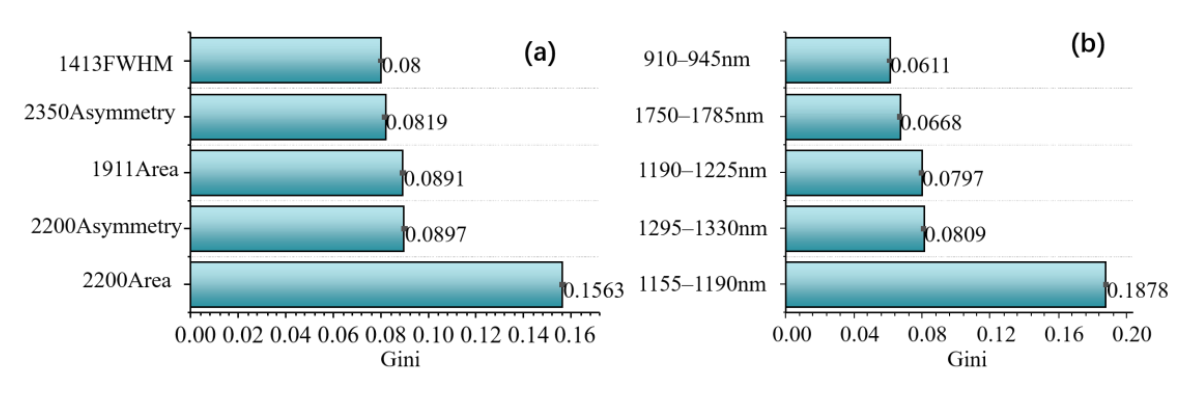
Figure 13. ( a , b ) Statistical chart of importance and the ranking of the predictors. The previous analyses, combined with the above indicative factors, have been used to map the absorption features, namely, the absorption wavelengths, areas, and depths. GF-5 advanced hyperspectral imaging (AHSI) was selected to extract the corresponding variables. The spectra around 1413 nm and 1911 nm of the GF-5 AHSI imagery cannot be used, due to an intense overprint caused by the corrections intended to remove the effects of atmospheric absorption from water vapor, and the stripe noise interference near 2350 nm is serious. Therefore, only the absorption features around 2200 nm were used to map in the GF-5 AHSI imagery, including the area around the 2200 absorption wavelength position (Figure 14a–c), 2200 Area (Figure 14d–f), absorption depth (Figure 14g–i) around 2200, and the first-order derivative of the bands (Figure 14j–l), while the random forest algorithm was used as the classifier. The results are shown in Figure 13, below. The layer-stacked image was then fed into the RF training model to recognize the distribution of the Li mine lithological classes (Figure 15). The metasediment of the Bayankalashan group of Triassic deposits shows an absorption position around 2200 nm at longer wavelengths, Li-rich pegmatite at shorter wavelengths, greater absorption area, and smaller absorption depth. The phenomenon is most obvious in Akesayi. However, these findings are all consistent with the characteristics of Li-rich micas that we mentioned earlier in this research. sified into the metamorphic rocks of the Bayankalashan group with a certain probability, especially in the Longmenshan mining area, with its narrow veins (0.6 m–15.1 m) and distribution. This may be because the spatial resolution of the Gaofen-5 data is only 30 m, which is much larger than the pegmatite vein scale. In the future, airborne systems with higher spatial resolution and a wider spectral range will have the advantage of the greater spatial identification of Li-rich